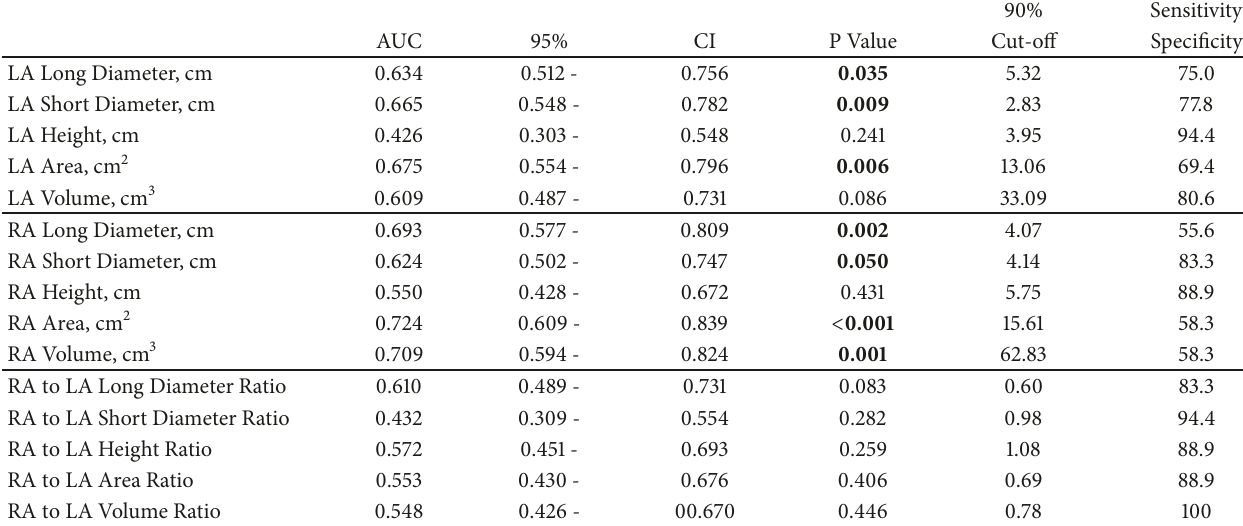
Table 3: ROC curve analysis of PAOI and different RA and LA